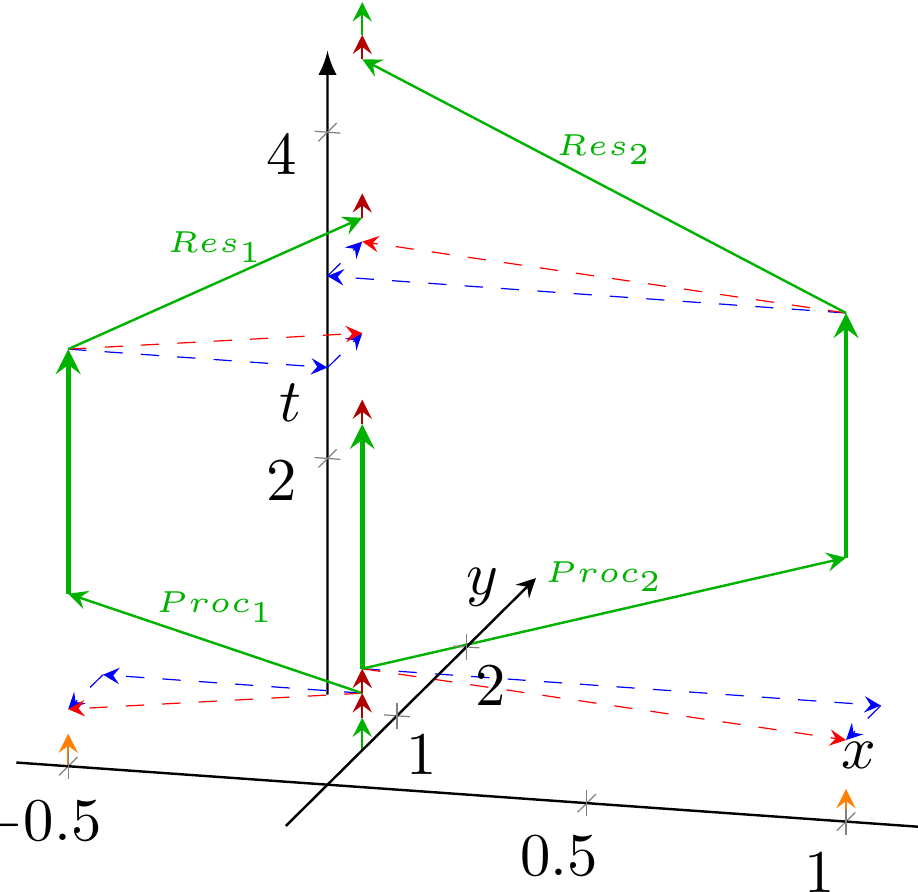
Figure 7. The operation of the “parallelized sequential” processing, in the time–space coordinate system. Parallel with axis t , the lack of vertical arrows signals “idle waiting” time, both for the coordinator and the fellow